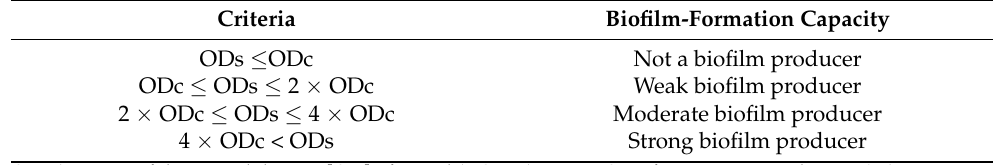
Table 2. Criteria used for the classification of UPEC according to biofilm capacity.